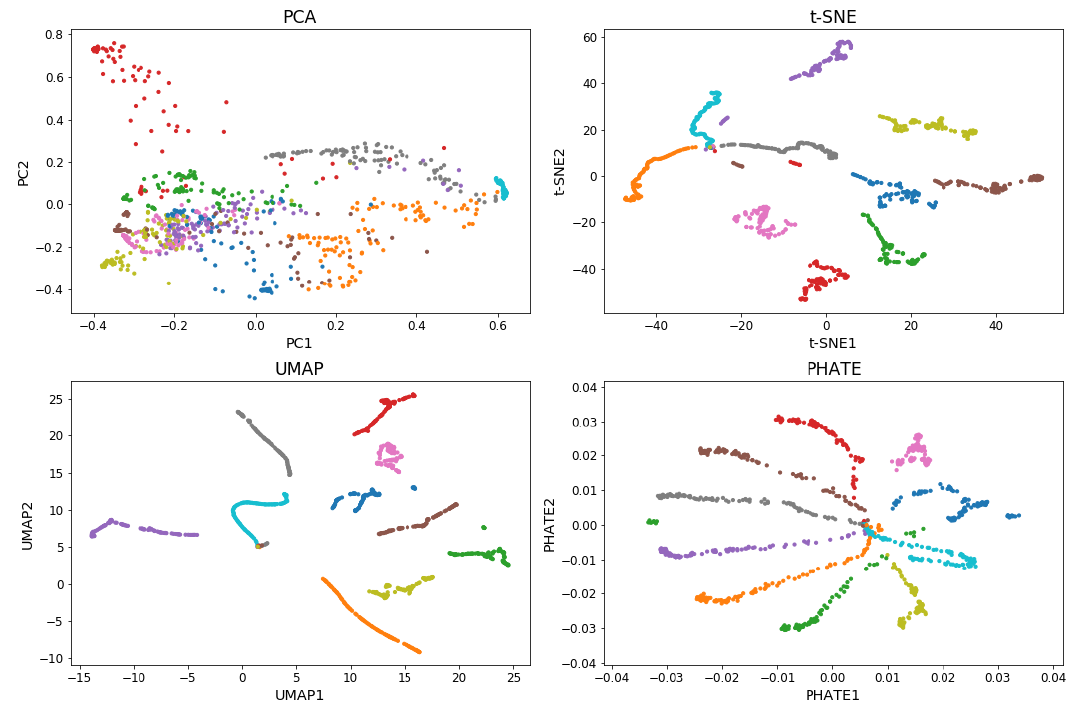
Figure 3. Comparison of principle component analysis (PCA), t-distributed stochastic neighbor embedding (t-SNE), uniform manifold approximation and projection (UMAP), and potential of heat-diffusion for affinity-based transition embedding (PHATE) for dimensionality reduction. The methods are applied to 2D embedding of simulated 10 trajectories (identified by color) of 100 -dimensional probability vectors, all originating from a common initial point. Except for PCA, all these methods are applied to the matrix of Hellinger distances. Only PHATE correctly captures the temporal progressions as distinct trajectories originating from a common initial